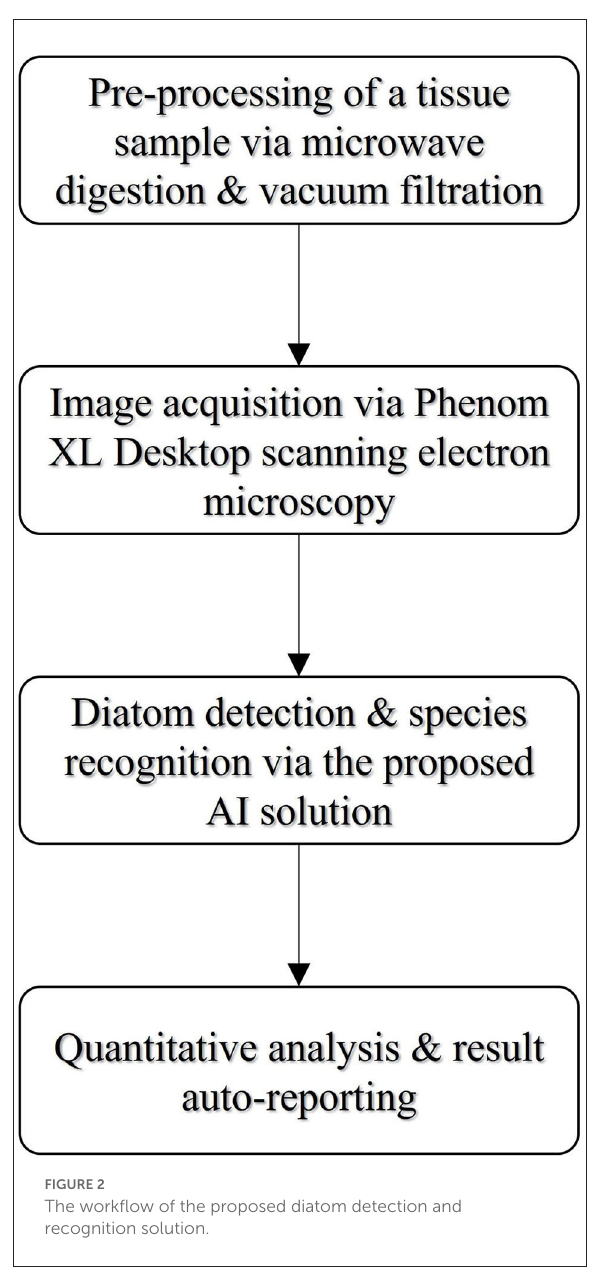
FIGURE2 The workflow of the proposed diatom detection and recognition